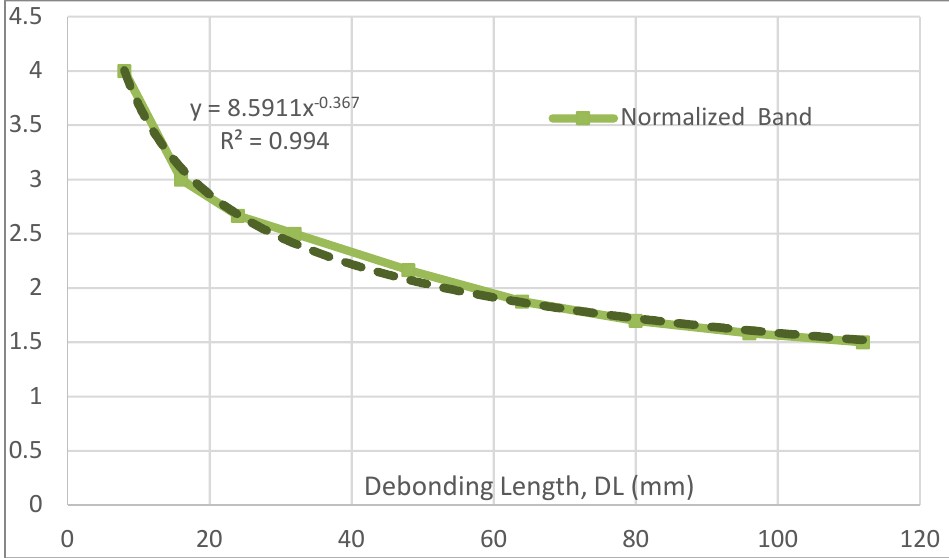
Figure 17. Normalized, non-dimensional damage effect width vs. actual debonding length.